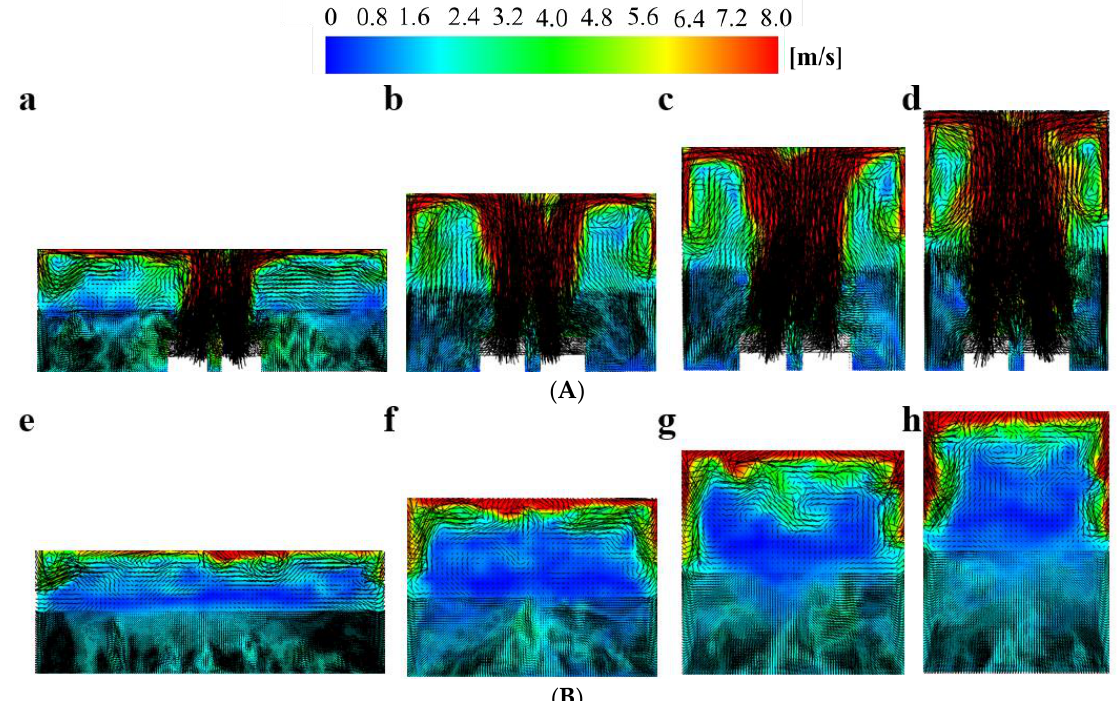
Figure 10. Visibility depending on distances, (A) represents on Fire plane, (B,C) represent the planes of 5 m and 10 m away from the fire sources, respectively. The aspect ratios of a, e, and I are 0.36, b, f, and j are aspect ratios of 0.72, c, g, and k are aspect ratios of 1, and d, b, and L are aspect ratios of 1.39.